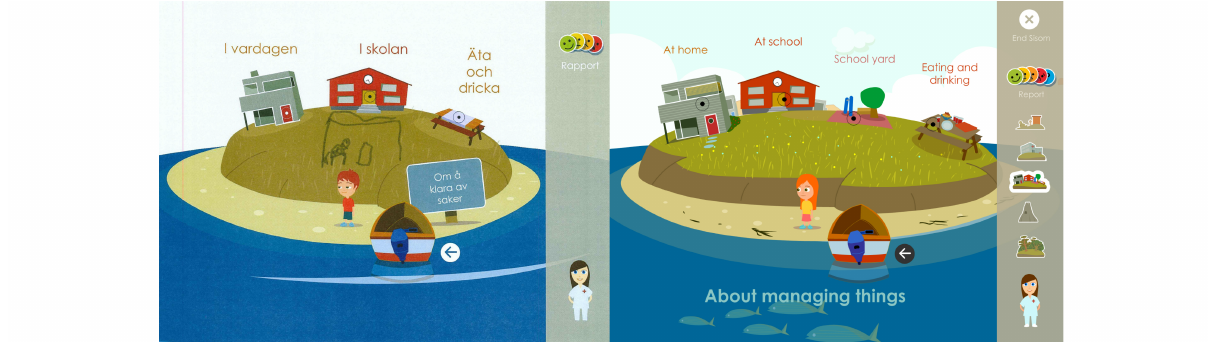
Figure 10. The children suggested that a schoolyard should be included at the school. Left: an example of what a child drew on a screenshot; Right: the final version in Sisom